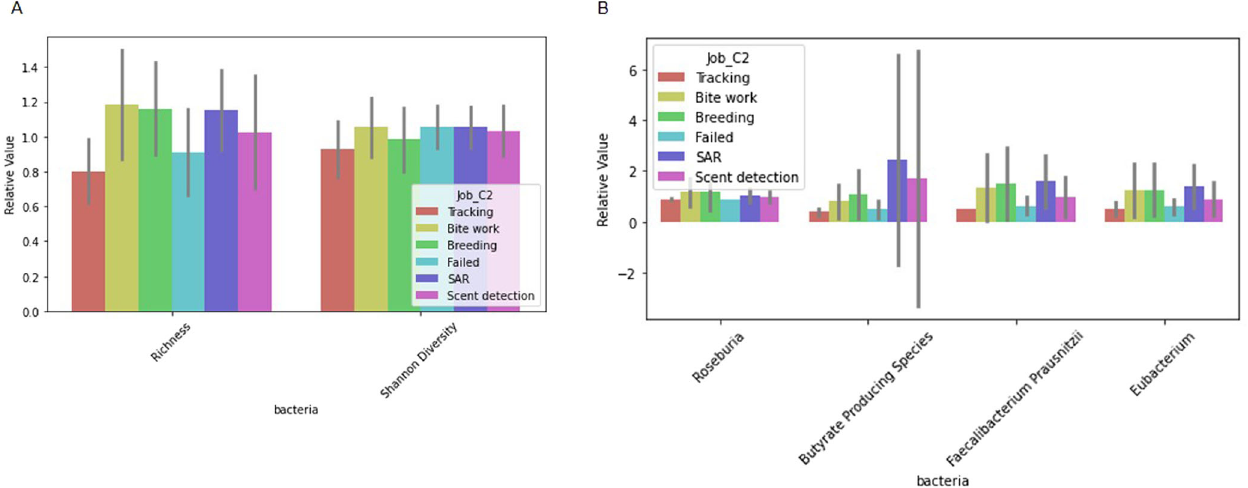
Fig. 4 Relative value of microbiome features that differed by canine job group and are statistically signi fi cant (Only associations signi fi cant via by Kruskal test, p < 0.05, are included). A Re fl ects differential value of richness and diversity, and B re fl ects relative abundance. Error bars represent con fi dence intervals. *SAR Search and Rescue. **Failed = Dogs that failed out of job training or failed to be assigned to job training.